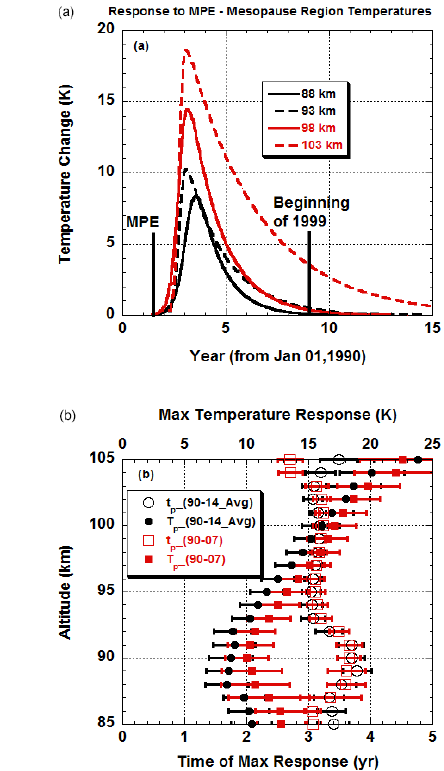
Figure 3. (a) Episodic warming in the 1990s at selected altitudes. By the beginning of 1999, the warming episode is basically over between 88 and 102km. (b) The peak temperature (maximum tem- perature response), T p , and the time at which it occurs (or the time of max response), t p , of warming episode deduced from 25-year data set (90-14_Avg) is shown in black solid circles and open circles, respectively. Results shown in red solid squares and open squares were deduced from the 18-year data set